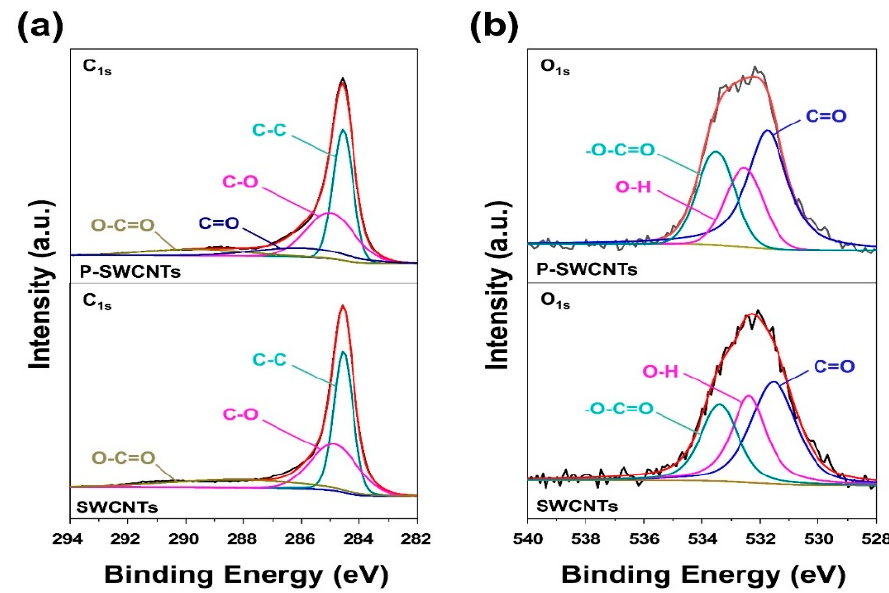
Figure 2. Characterization of SWCNTs and P-SWCNTs: ( a ) C 1s and ( b ) O 1s core level of XPS spec- tra.